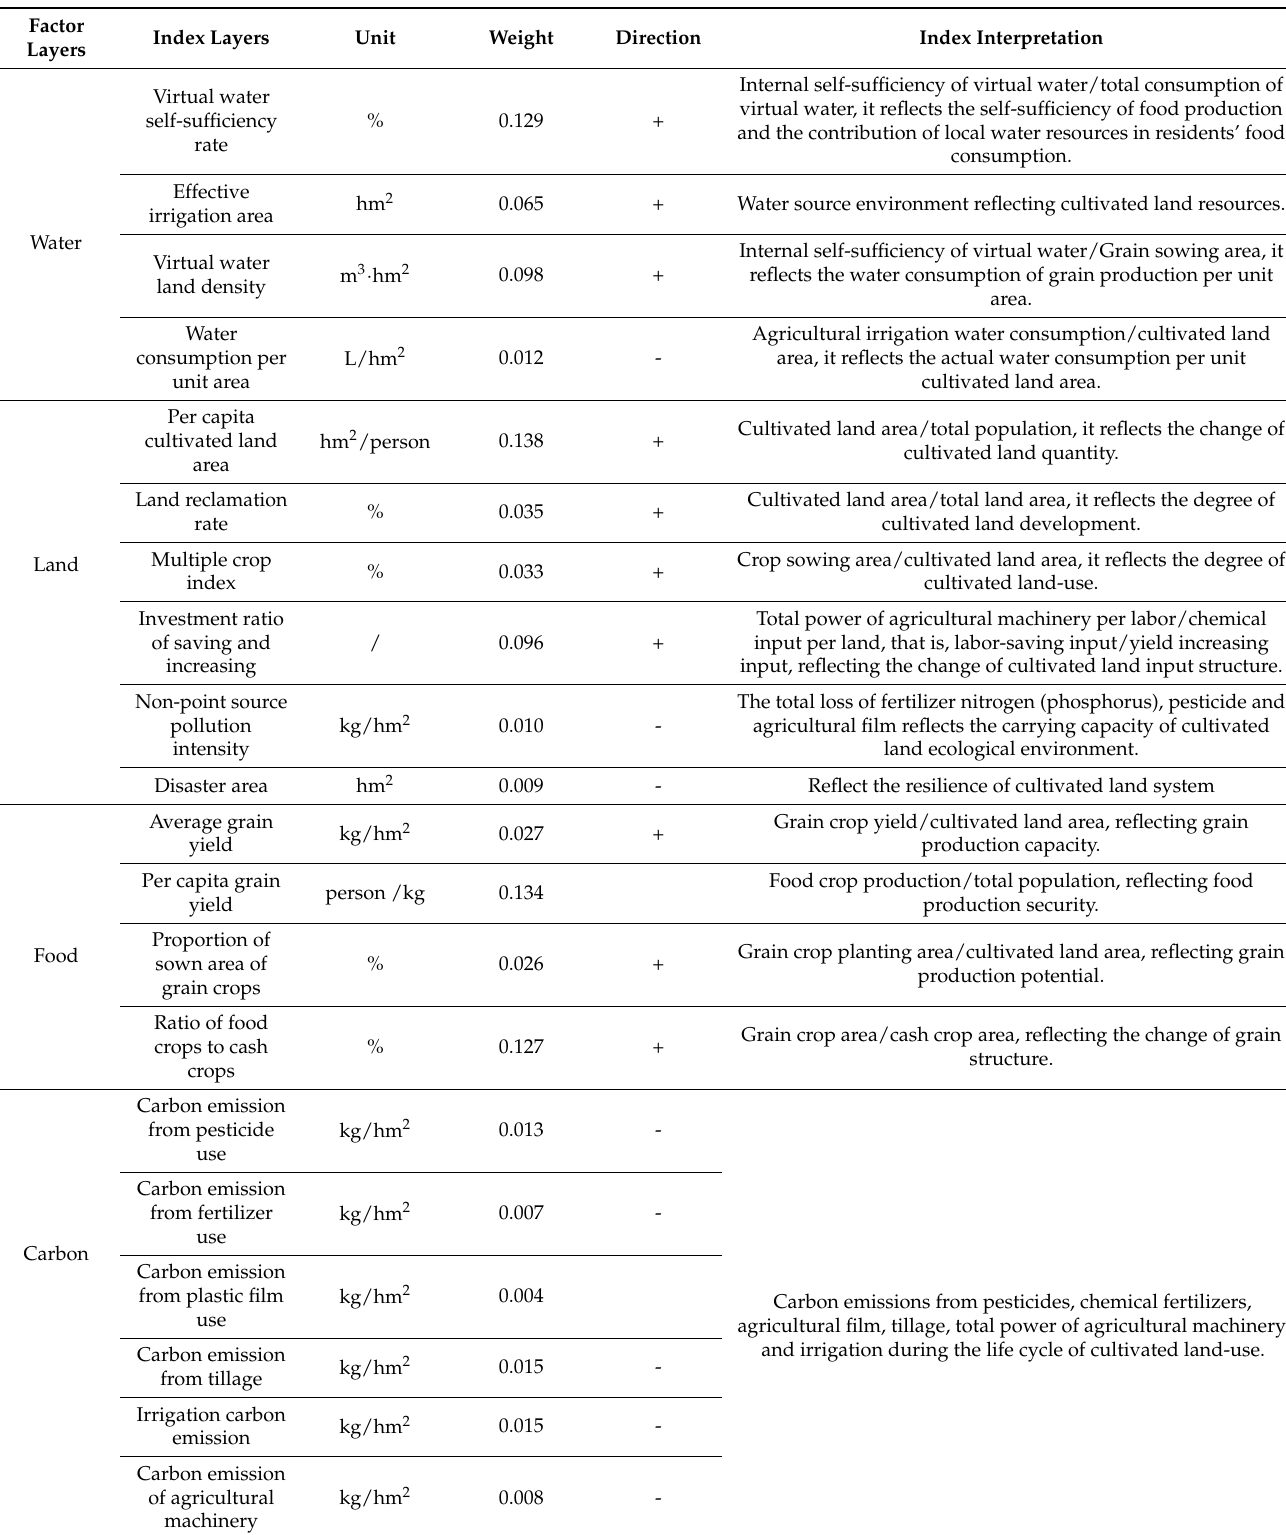
Table 1. Index system of